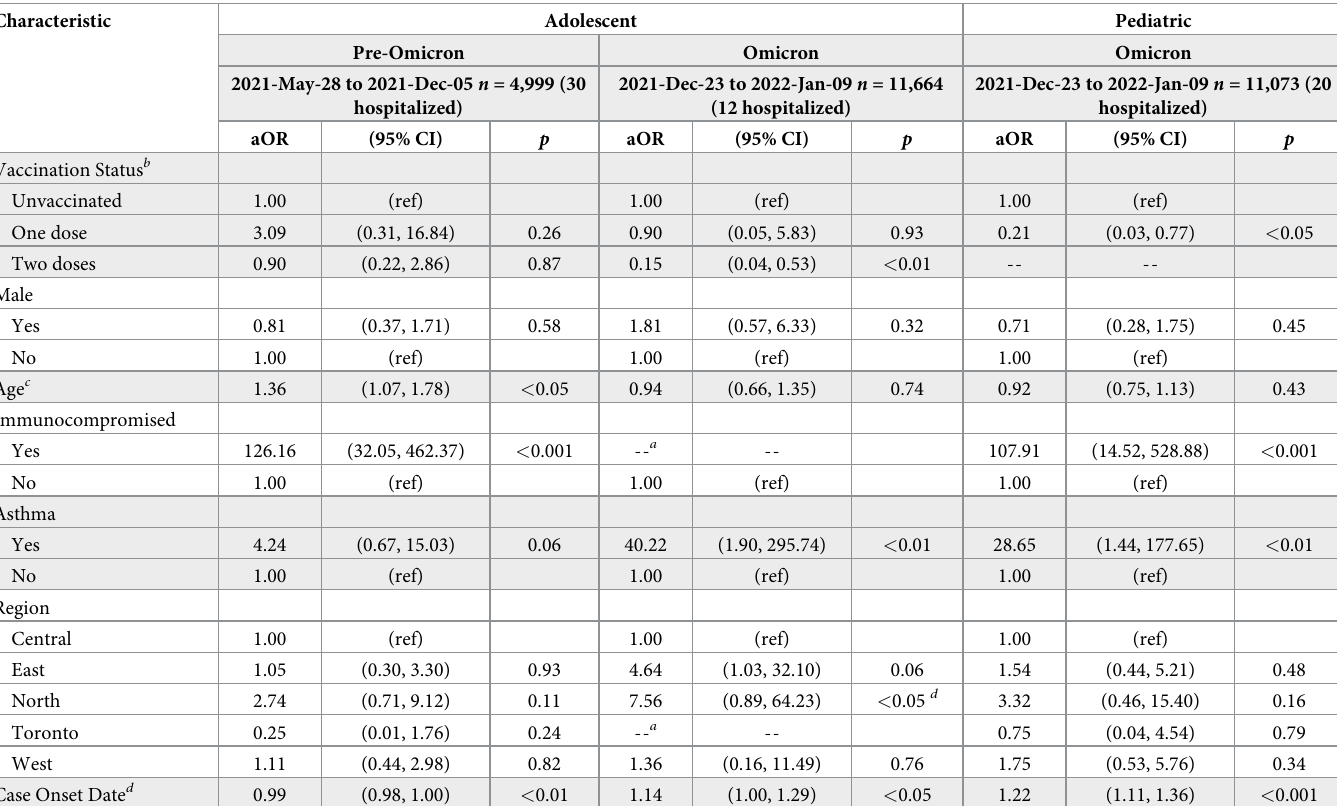
Table 2. Adjusted odds ratios of the association between vaccination status and hospitalization among adolescent and pediatric SARS-CoV-2 cases ( n = 27,736).